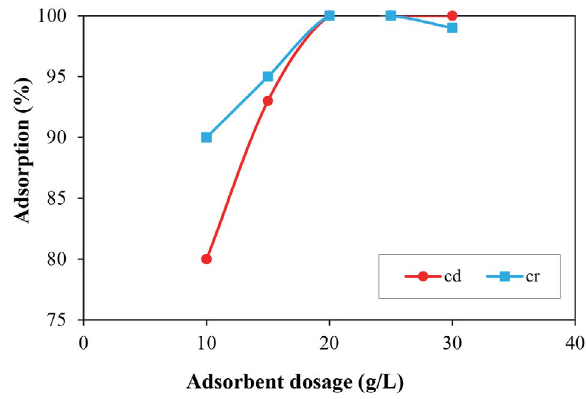
Fig. 8: The effect of cobalt-ferrite magnetic nanocomposite on the percentage remove of cadmium and chromium in conditions in terms of (cadmium pH: 6, chromium pH: 7, initial ion concentra- tion 20 mg/L, time 50 min and temperature 25 °C)